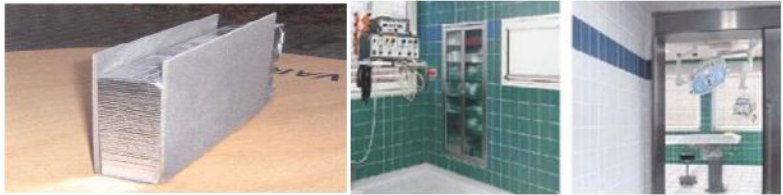
Figure 9. (VIPs) panels used in Operating theatre, Goslar,(Atwa, Al-Kattan, &Elwan, 2015, p. 3551-3564)